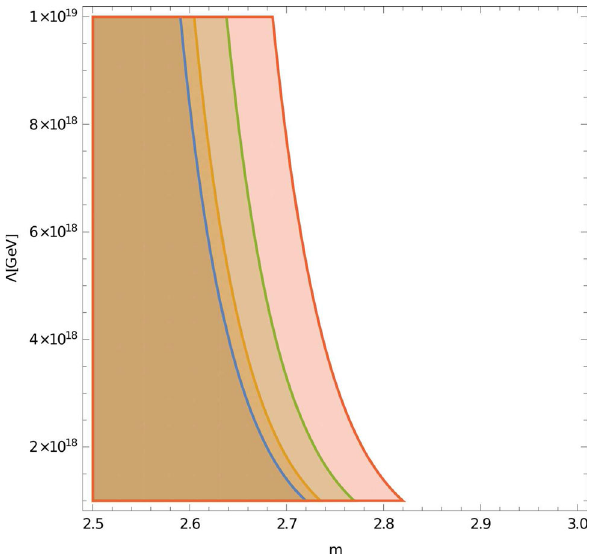
Fig. 1 Excludedparameterspace ((cid:14), m ) fromDAMAexperiment:the four contour limits correspond to fix n = 1 , 2 , 10 , 100 respectively